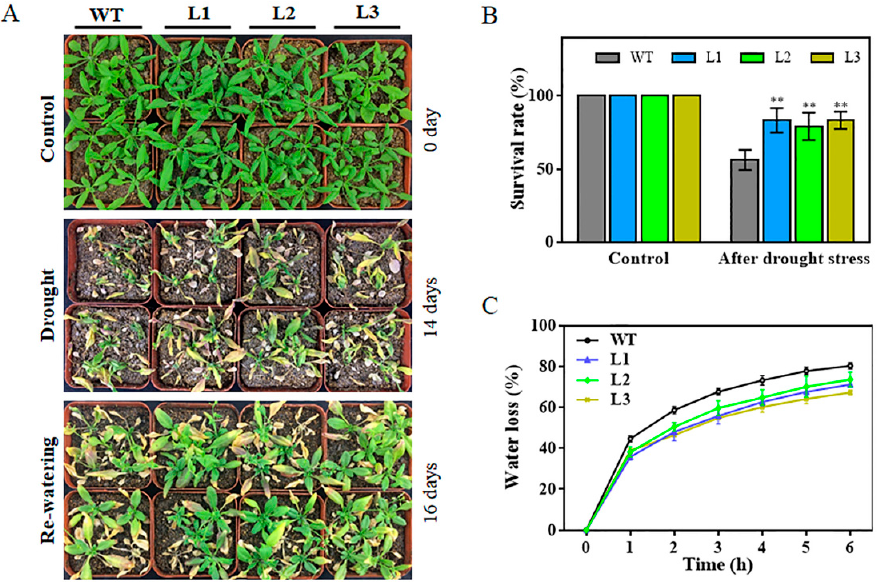
Figure 4. Comparison of drought tolerance among WT and three TaHsfA6f overexpressing lines. ( A ) Drought-tolerant phenotypes and ( B ) survival rates of WT and transgenic lines. Water was withheld for 14 days; afterwards, re-watering was applied and survival rates were calculated two days after re-watering. ( C ) Water loss rates of WT and transgenic lines. The data presented are means ± SD of three replicates (** p < 0.01 by Student’s t -test).